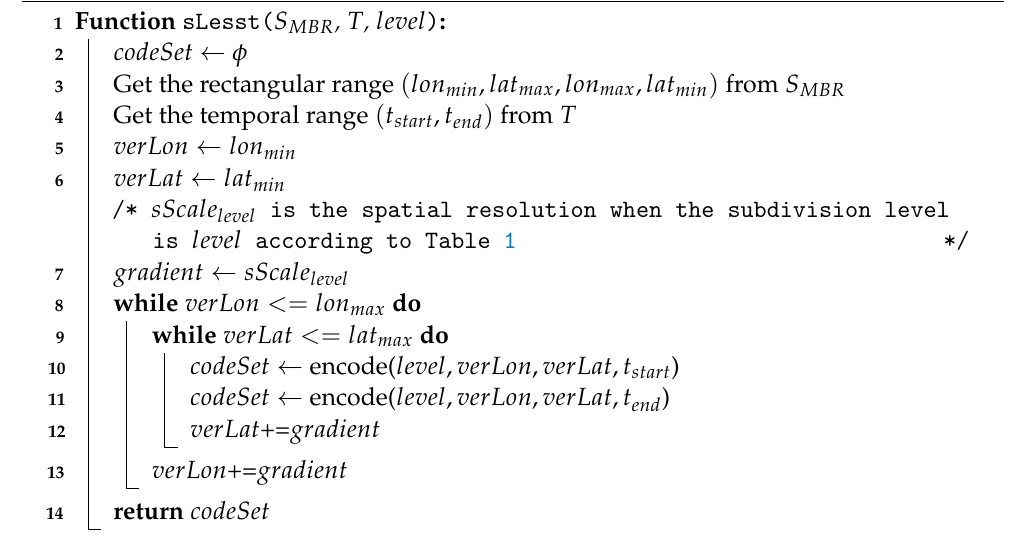
Algorithm 4: The query for a short time range and a large spatial